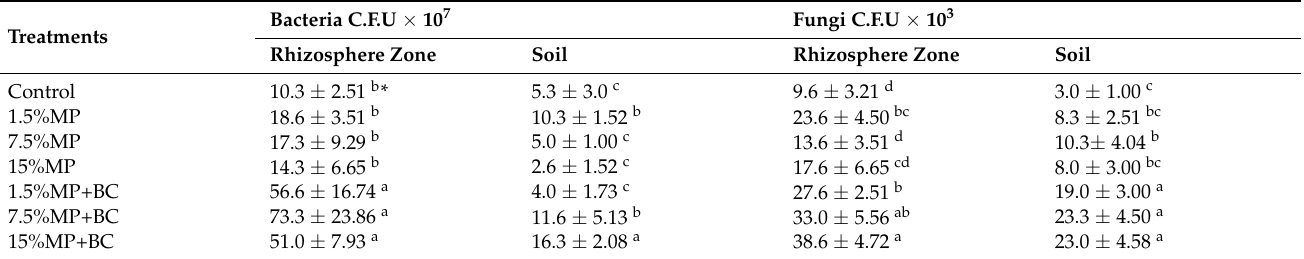
Table 9. Effect of microplastic and biochar treatment on total count of bacteria and fungi.